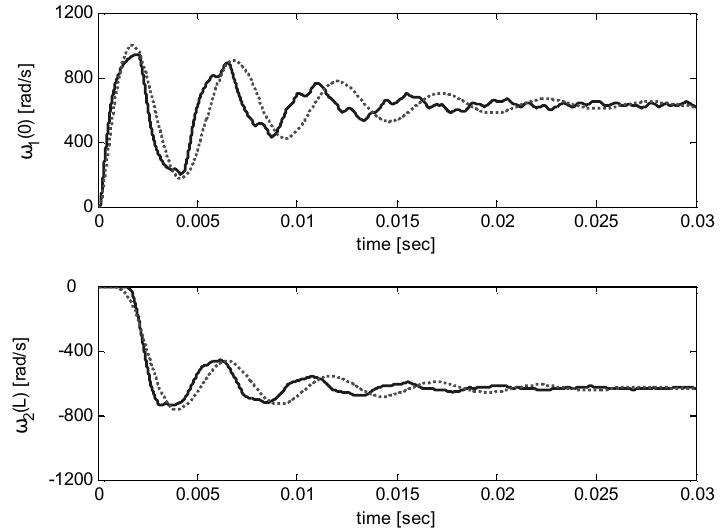
Fig. 12. Angular velocity at the actuation and load ends. Solid – transfer function model, dotted – lumped approximation.